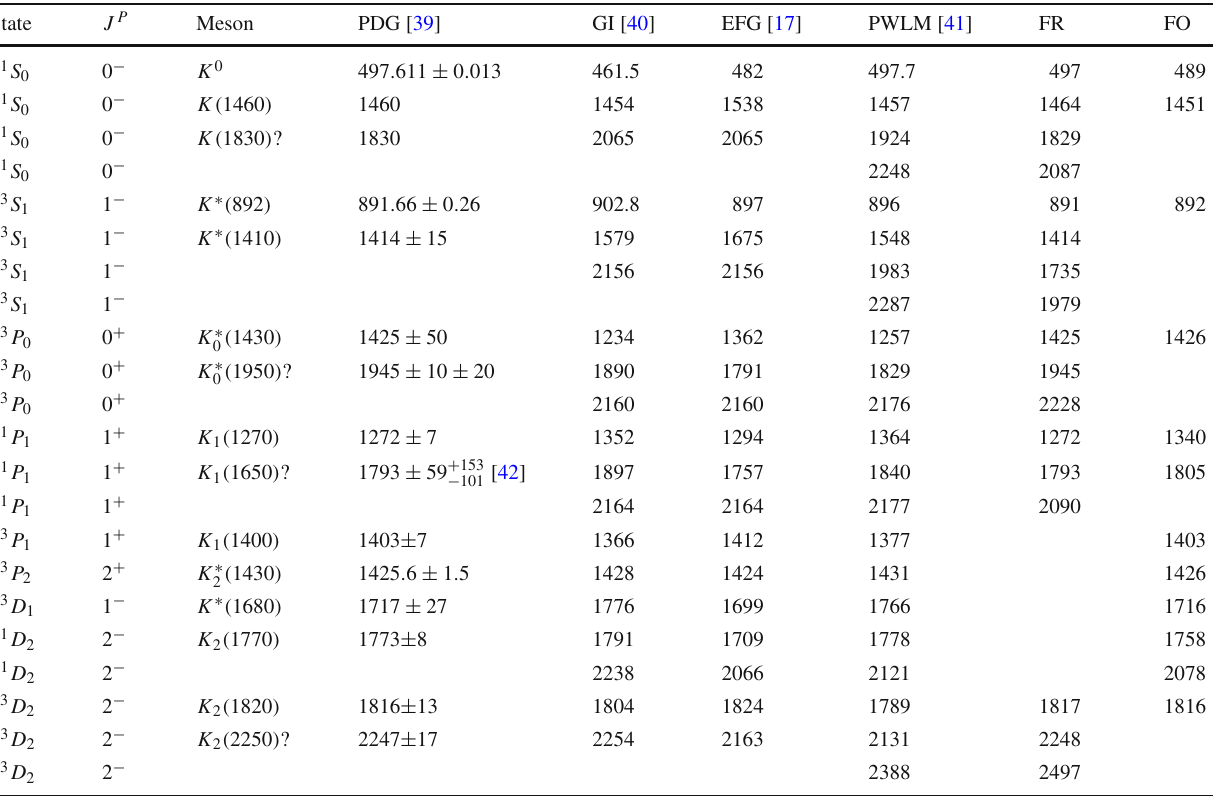
the unwell-established states or the mesons needing confirmation. FO and FR denote the fitted results by the orbital Regge trajectories and by the radial Regge trajectories,